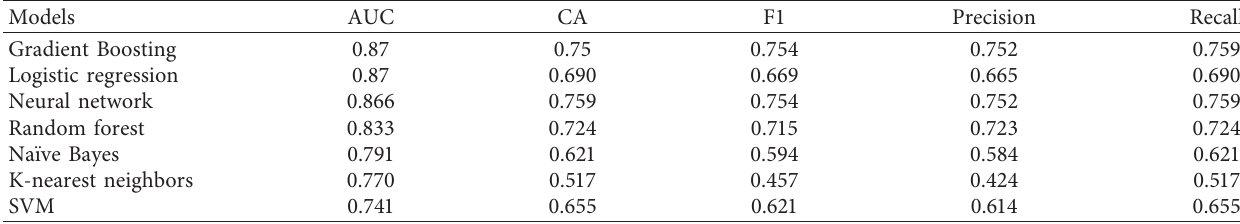
Table 1: Machine learning algorithms’ performance (data from